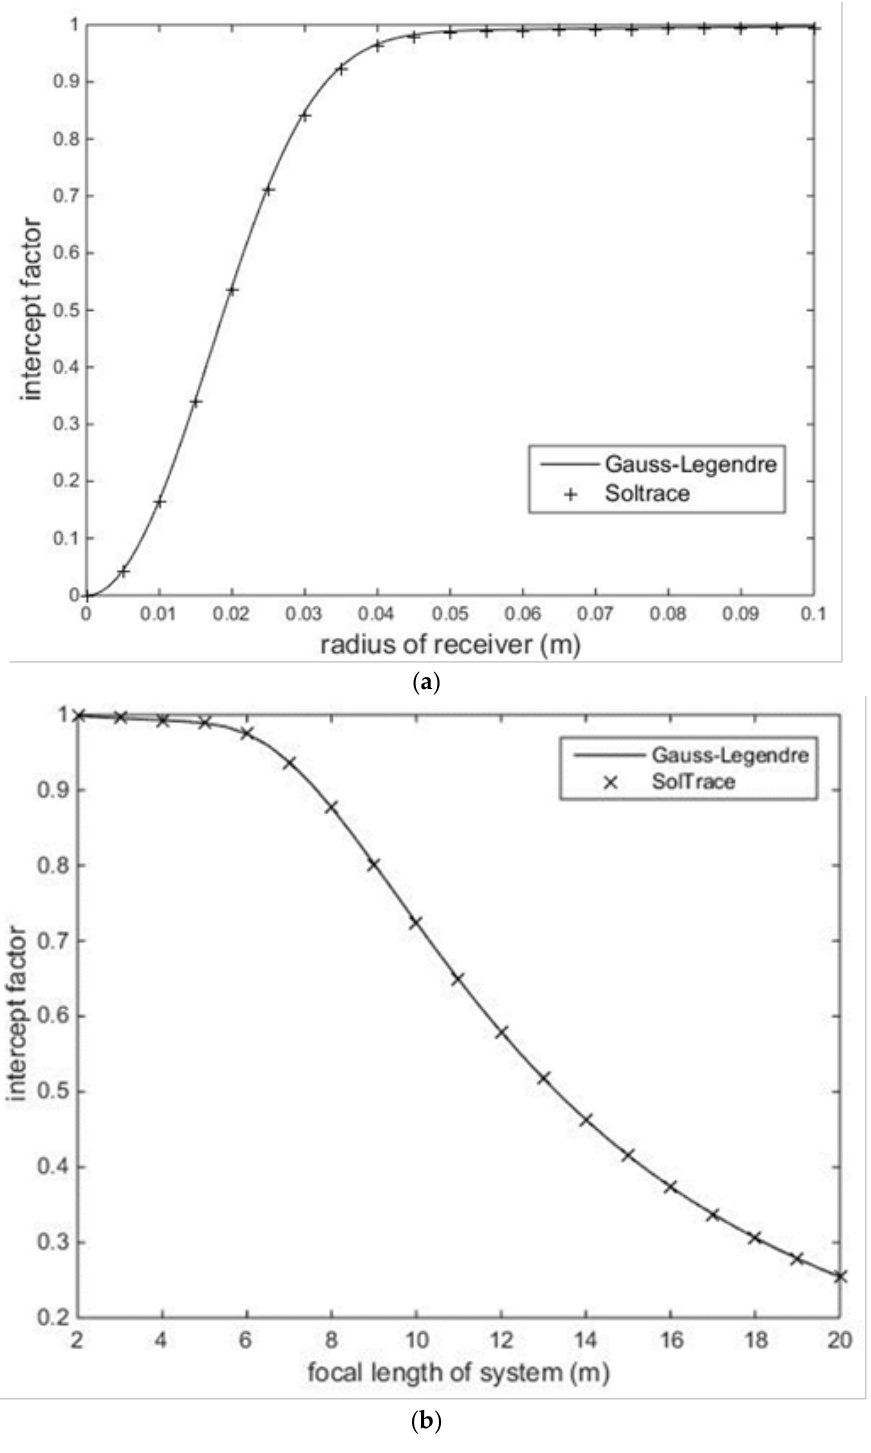
Figure 4. Validation of the intercept factor of 3 m × 3 m combined dish system with different receiver radius ( a ), and system focal length ( b ).